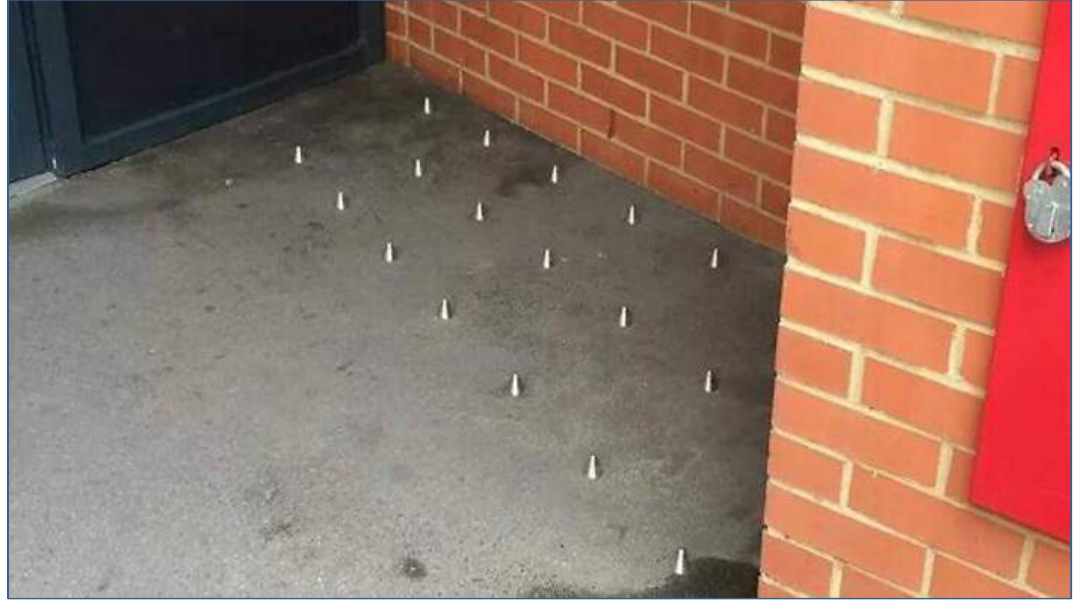
Figure 1: ‘Anti ‐ homeless’ spikes installed in an apartment building entrance in South London Source: